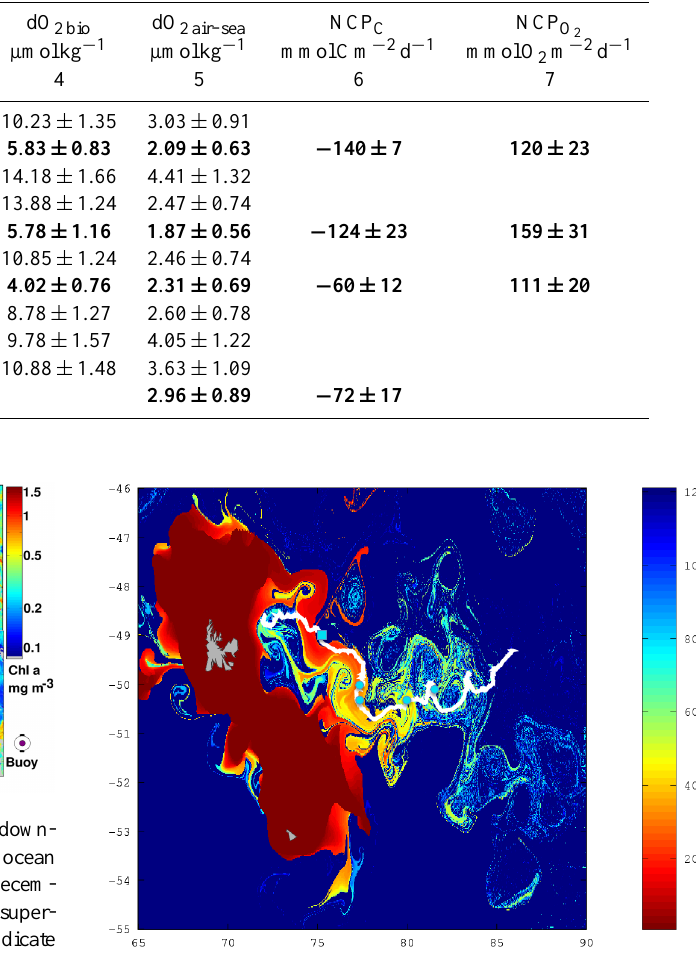
Figure 4. Lagrangian perspectives on large-scale natural iron fer- tilization on the Kerguelen Plateau and in the downstream plume: a snapshot on 25 November 2011. The color coding indicates the time in days since leaving the plateau for each water parcel (d’Ovidio et al., 2015). The white line indicates the trajectory of the CARIOCA drifter from 1 November to 31 December 2011. The cyan dots indi- cate the locations where carbon NCP estimates are calculated. The cyan square is the position of the buoy on 16 November (see